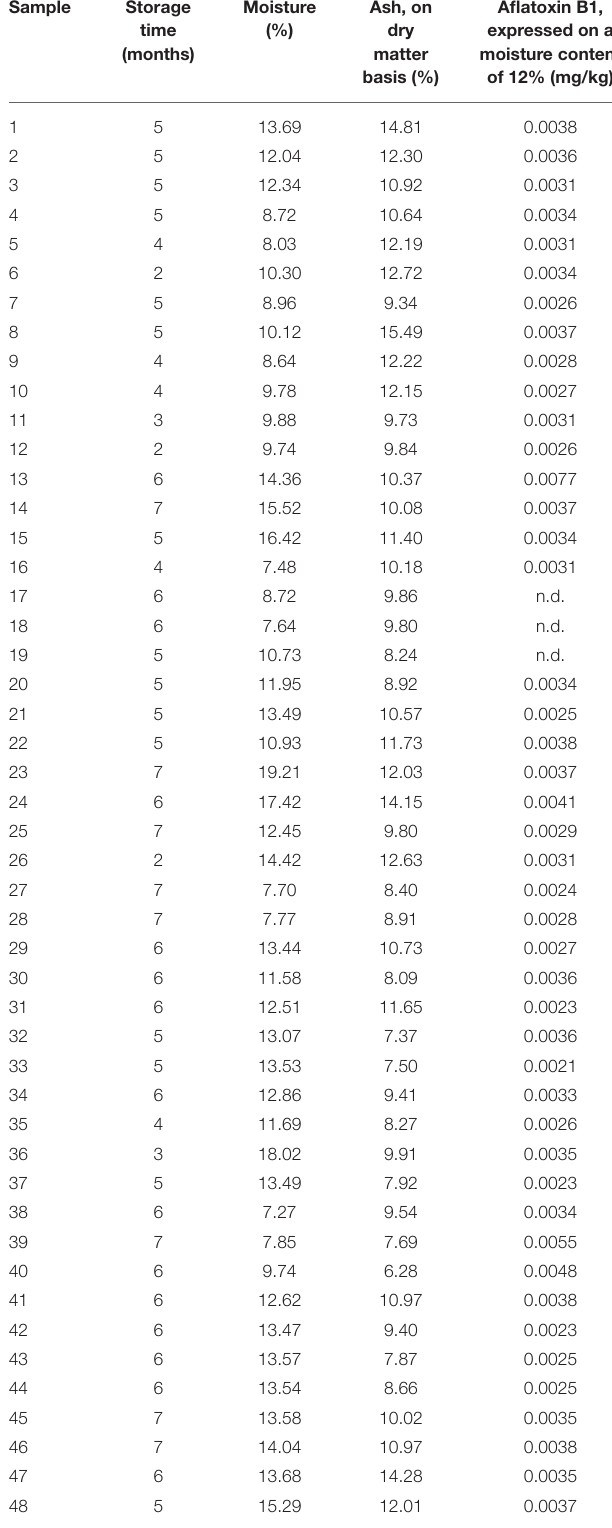
TABLE 1 | Storage time, moisture, ash, and aflatoxin B1 (AFB1) of hay samples. Sample Storage Moisture time (months)